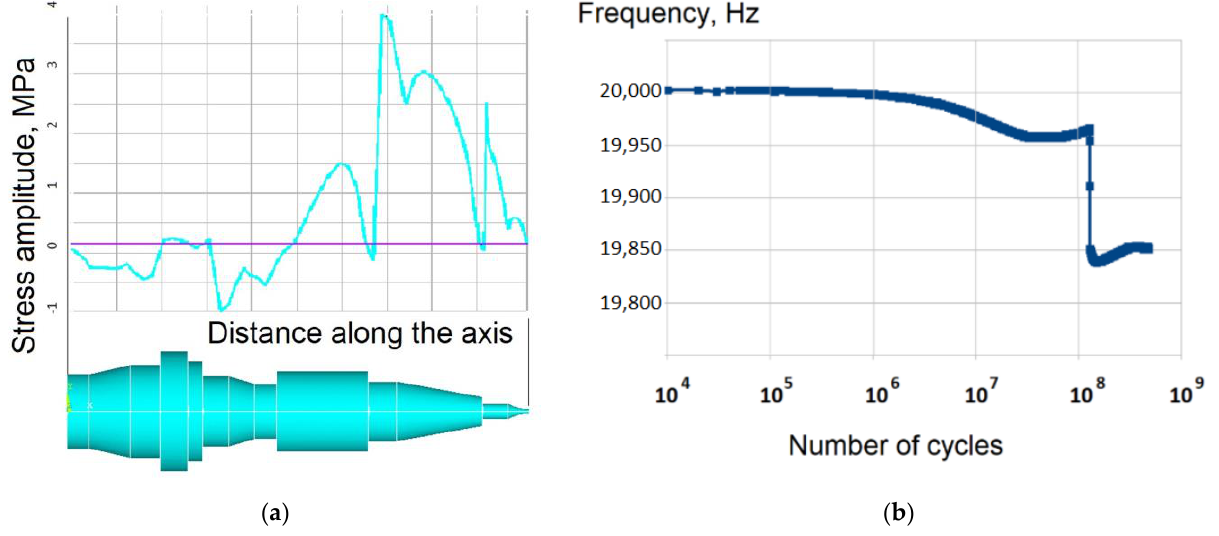
Figure 2. The numerical simulation of VHCF system with a half of aluminum specimen ( a , b ) results of resonant frequency drop for hot-rolled aluminum